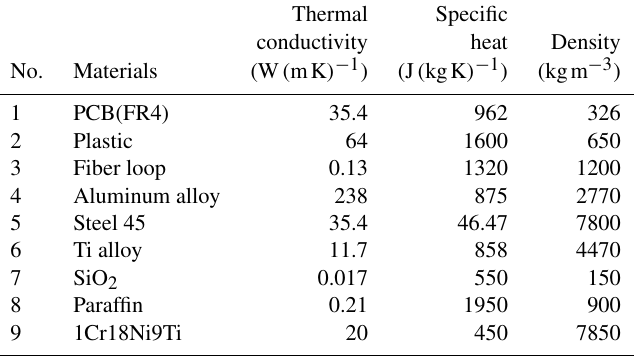
Figure 15. (a) The trend diagram of the maximum equivalent stress of tube body with thread increases; (b) the trend diagram of the maximum total deformation of tube body with thread increases. Table 5. Material property parameters of various materials of the metal vacuum flask. Thermal